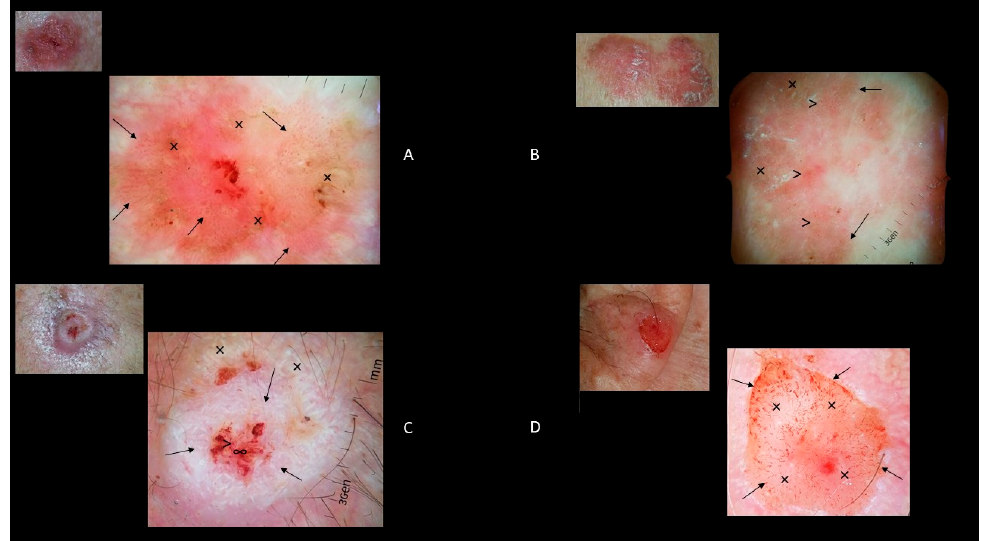
Figure 4. ( A ): Clinical image of a 12 × 8 mm nonpigmented Bowen’s disease of the chest with dermoscopic features of dotted and glomerular vessels ( ↑ ) and scaly white-to-yellow surfaces ( × ). ( B ): Clinical image of a 30 × 12 mm pigmented Bowen’s disease of the leg with dermoscopic features of brown to gray globules/dots ( ↑ ) and structureless pigmentation ( × ) and dotted and glomerular vessels (>). ( C ): Clinical image of a 14 × 11 mm well differentiated cSCC of the scalp with dermoscopic features of keratin/scales ( ↑ ), blood spots (>), white structureless areas ( × ), and ulcerations ( ∞ ). ( D ) Clinical image of a 7 × 6 mm poorly differentiated cSCC of the ear with dermoscopic features of hairpin and linear-irregular vessels ( ↑ ) and ulcerations ( ×